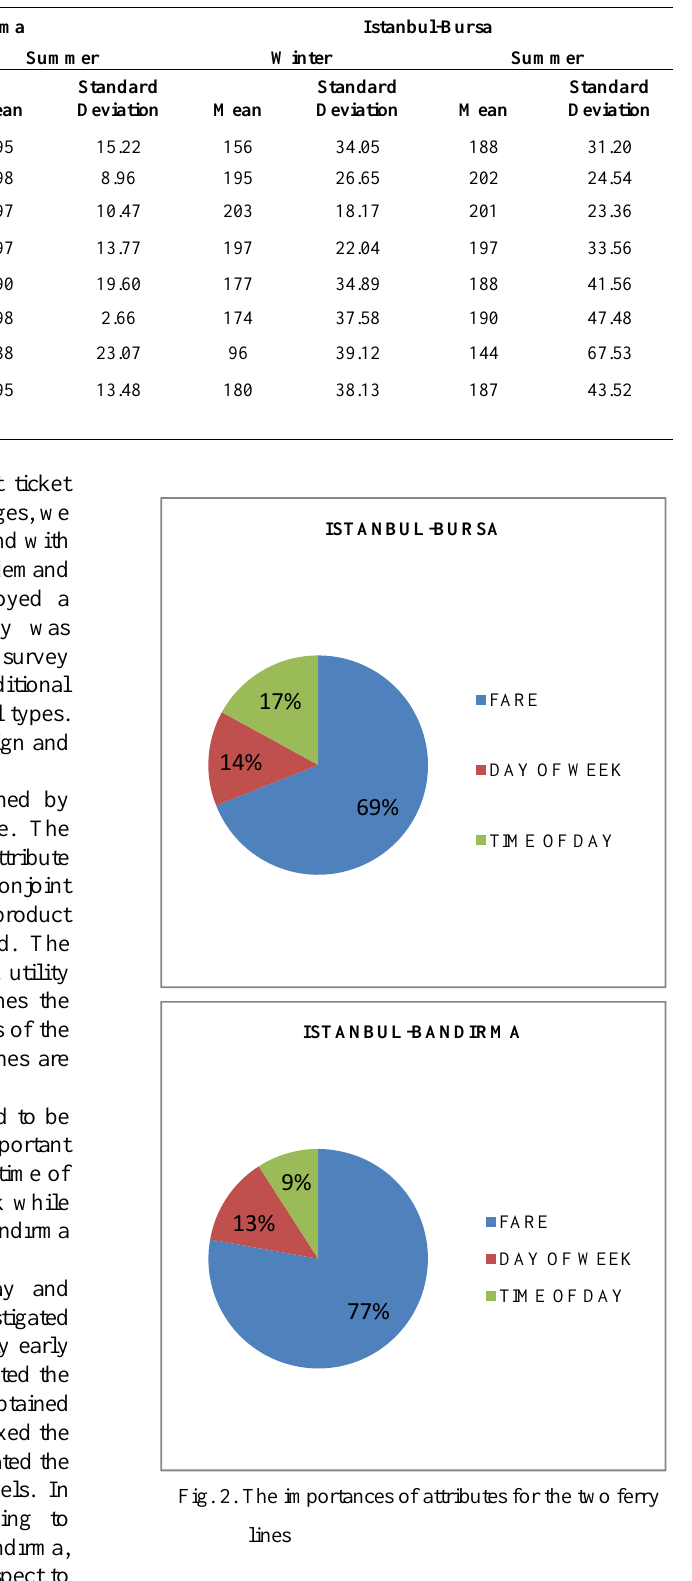
Table 3. Mean and standard deviation of number of sold seats.